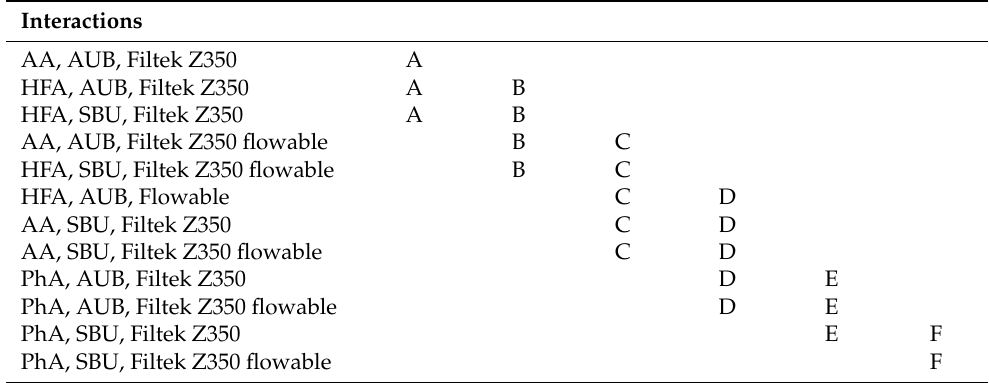
Table 3. Post hoc Tukey test showing the interaction between the three factors: conditioning meth- ods, bonding agents and composite types ( p < 0.05).